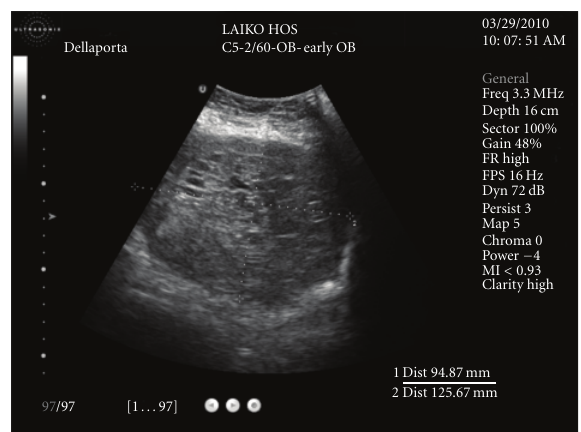
Figure 1: Explanatory legend: Transvaginal ultrasound of the pa- tient. Snowstorm-like appearance. Uterus dimension: 94,87mm ×